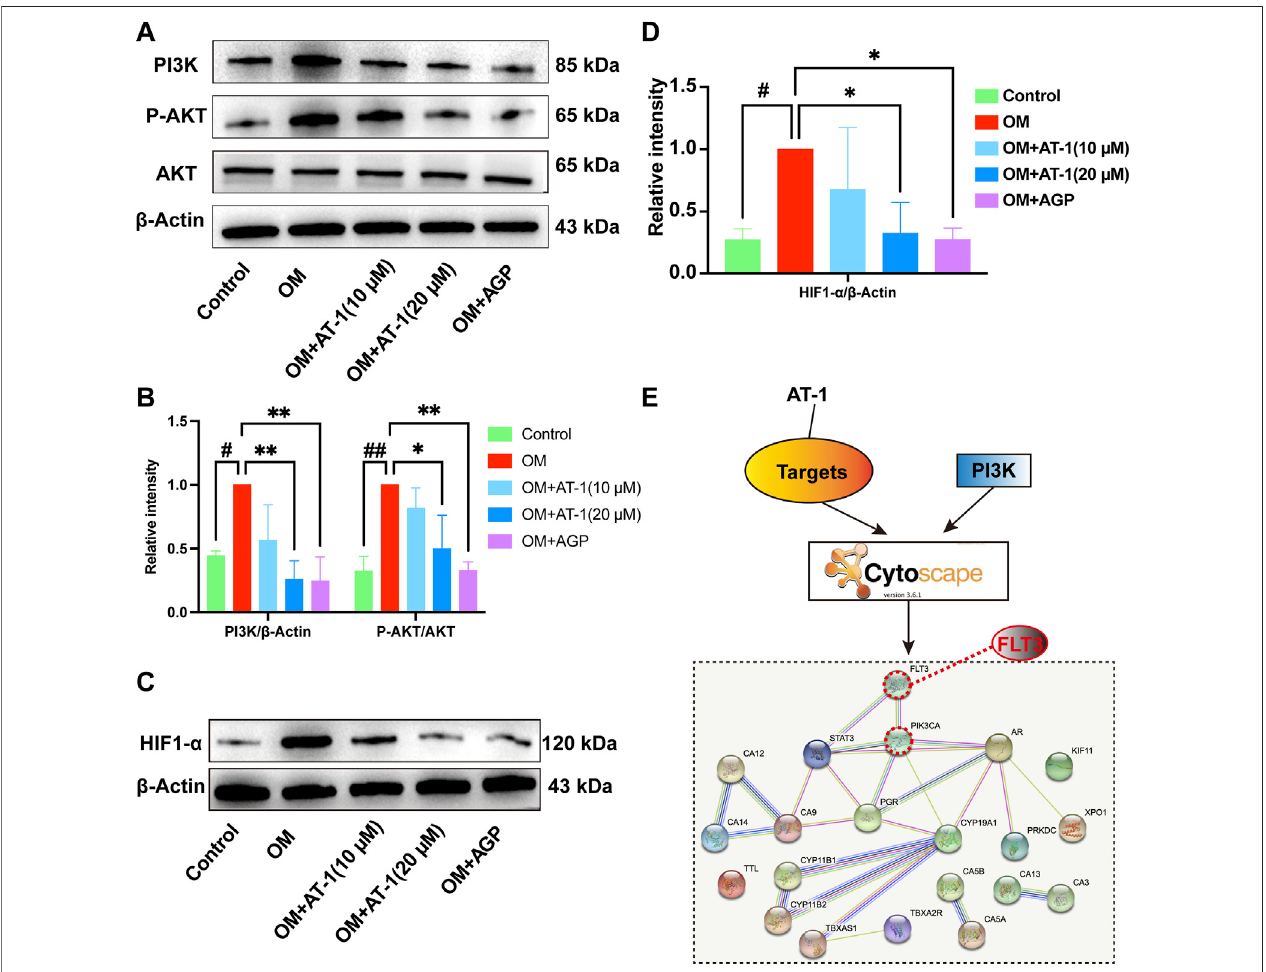
FIGURE4| TheeffectofAT-1onthePI3K/AKT/HIF1- α pathwayandinvestigationsintoitsupstreamtargets. (A) EffectofdifferentAT-1andAGPconcentrationson the expression of PI3K, AKT, and P-AKT proteins (B) Statistical analysis of PI3K/ β -actin and P-AKT/AKT. (C) Effect of different AT-1 and AGP concentrations on the expression of HIF1- α protein. (D) Statistical analysis of HIF1- α / β -actin. (E) The predicted AT-1 targets and PI3K pathway proteins were subjected to PPI network association analysis to identify the upstream targets of AT-1 regulating the PI3K pathway. * p < 0.05, ** p < 0.01 indicated a signi fi cant difference compared to the control group and # p < 0.05, ## p < 0.01 indicated a signi fi cant difference compared to the OM group, n = 3.